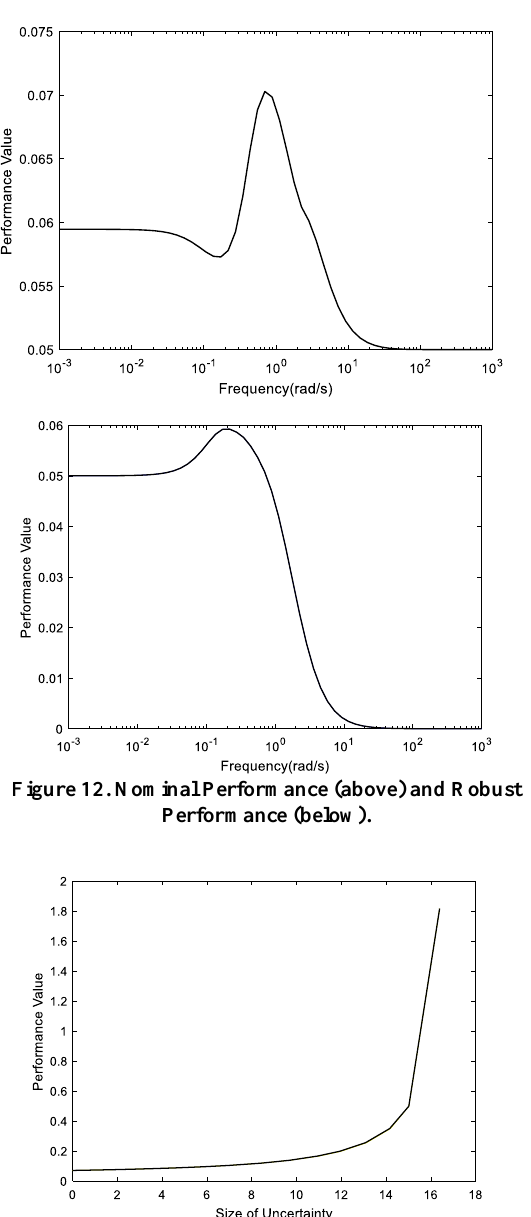
Figure 13. Worst-Case Performance with H-infinity Controller.